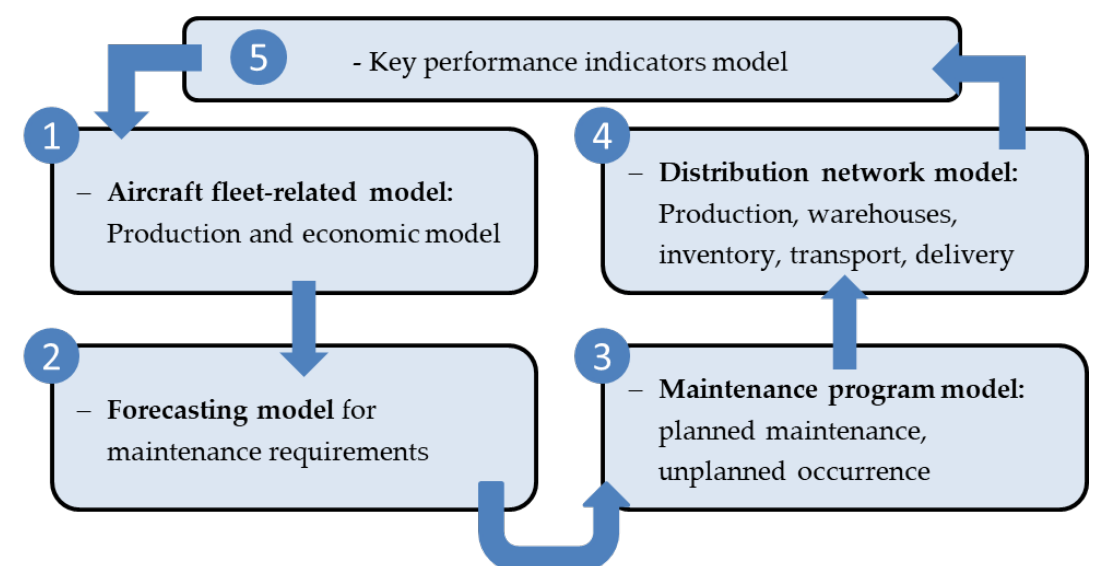
Figure 6. System dynamics model and its five sub-models (own elaboration).